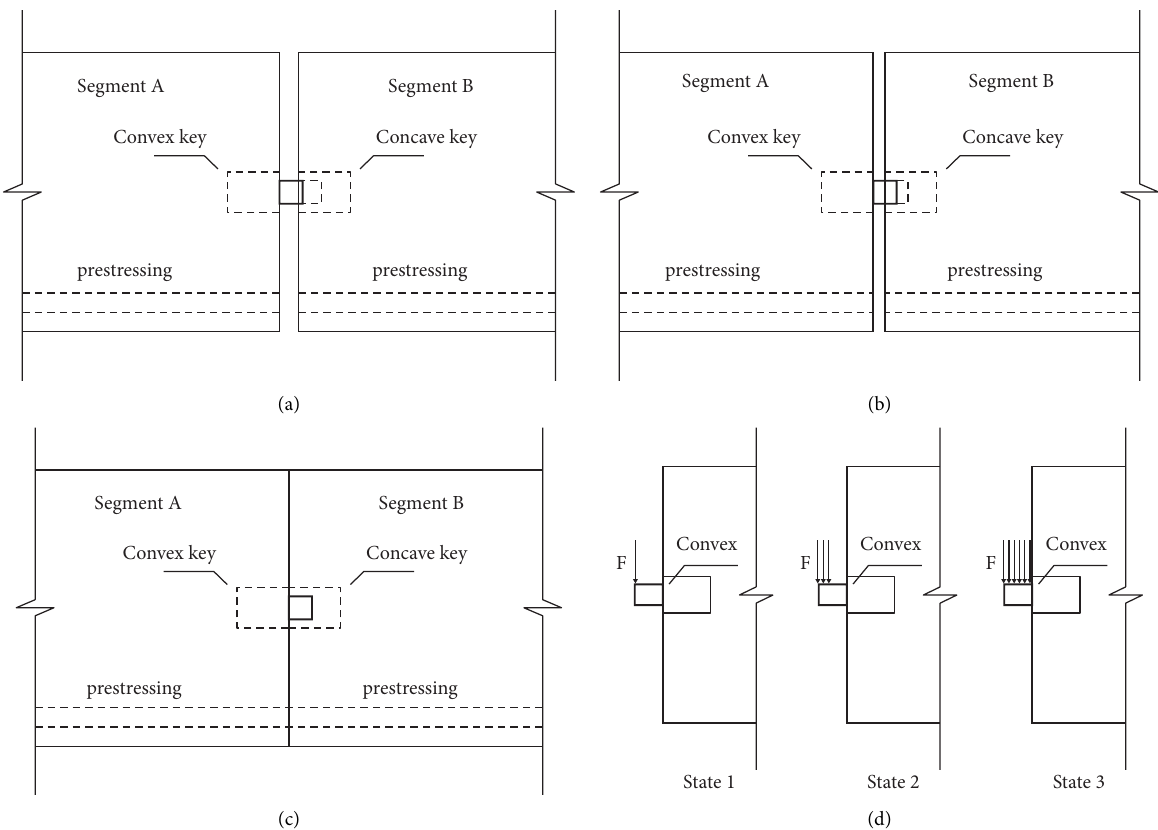
Figure 12: Stress state of steel shear keyed joints during construction process. (a) State 1: initial butt joint, (b) State 2: half butt joint, (c) State 3: full butt joint, and (d) simplified mechanics.